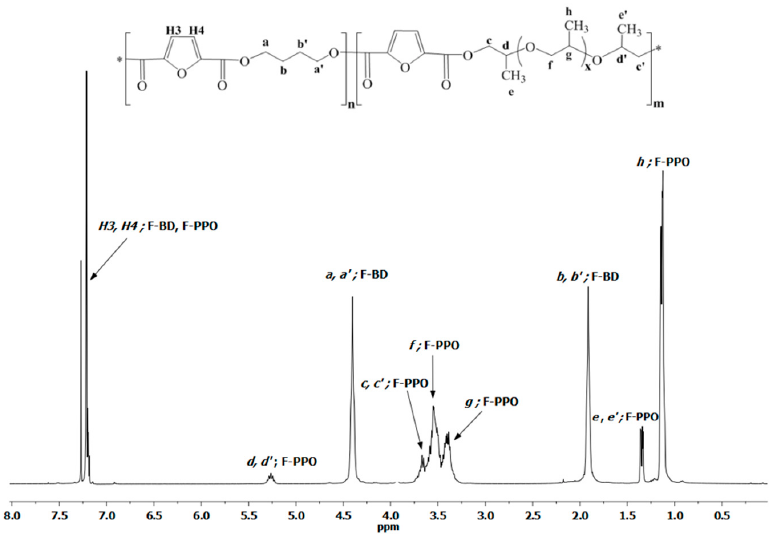
Figure 2. 1 H NMR spectrum of PBF- co -PPOF-90/10 co-polymer in CHCl 3 - d . Table 2. Main 1 H NMR resonances of PBF- co -PPOF co-polyesters, and PBF and PPO homopolyesters. The a, b, c, d, e, f, g and a (cid:48) , b (cid:48) , c (cid:48) , d (cid:48) , e (cid:48) attributions are explained in the scheme of Figure 2.